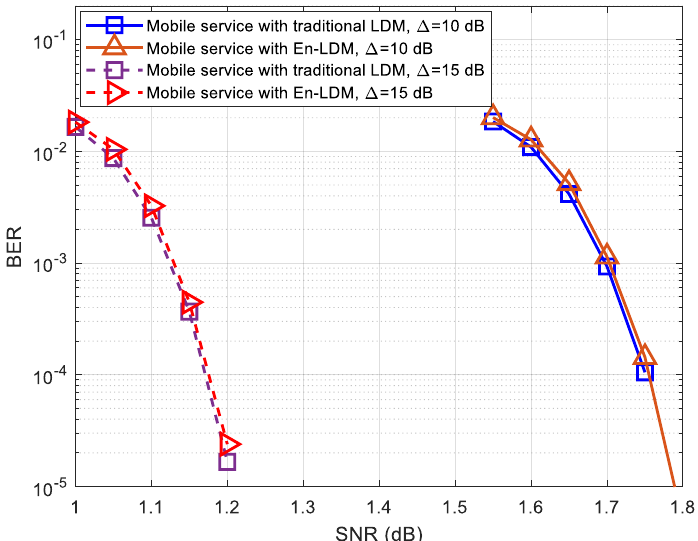
Figure 8. BER performance of mobile service with En-LDM and traditional LDM systems under the multipath channel, where the injection levels were set to 10 dB and 15 dB, the CL constellation was set to QPSK, the EL constellation was set to NU−64QAM, the puncturing rate of the En-LDM scheme was set to 1/13, and the LDPC code rates of CL and EL were set to 5/15 and 11/15, respectively.